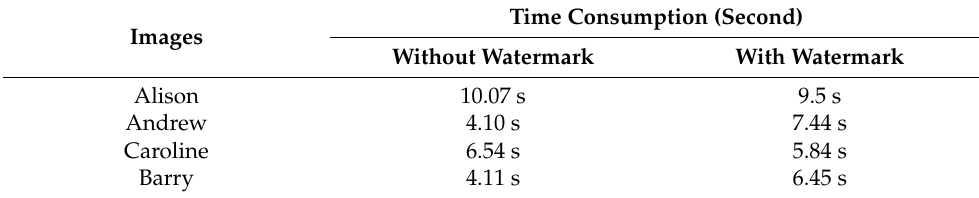
Table 5. Time consumption of the TattooCam